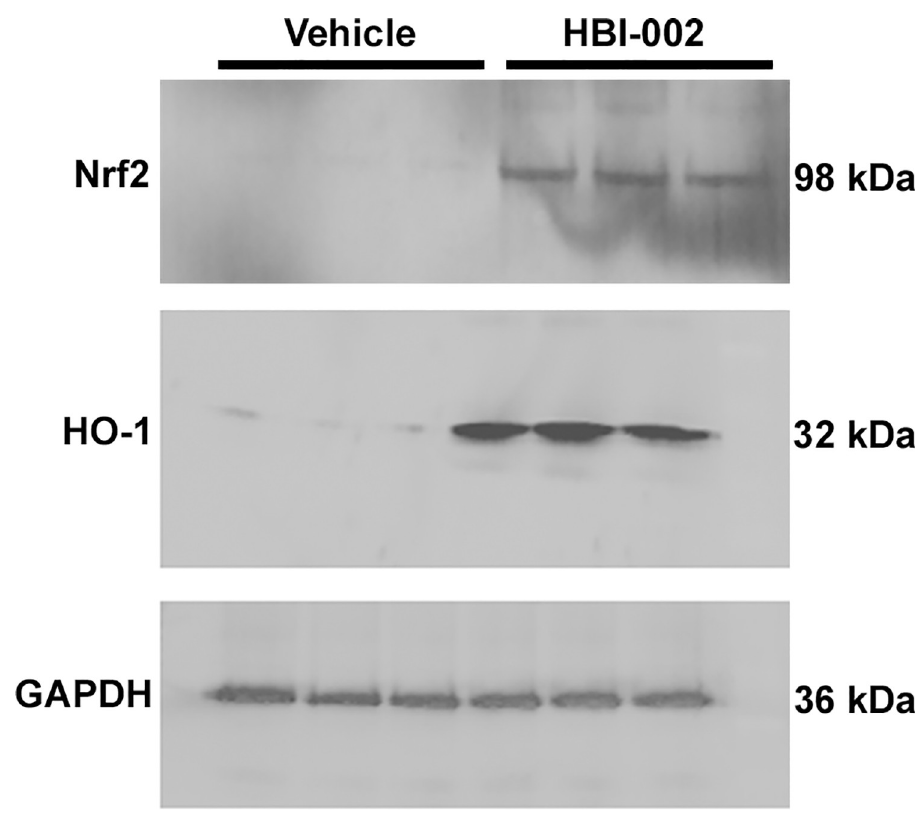
Fig 3. HBI-002 increases hepatic Nrf2 and HO-1 expression. Townes-SS mice (n = 3/group) were gavaged once- daily with HBI-002 or vehicle (10 ml/kg). On day 10 of treatment the livers were removed and frozen. Nrf2 and HO-1 expression was examined on immunoblots of hepatic nuclear extracts and microsomes